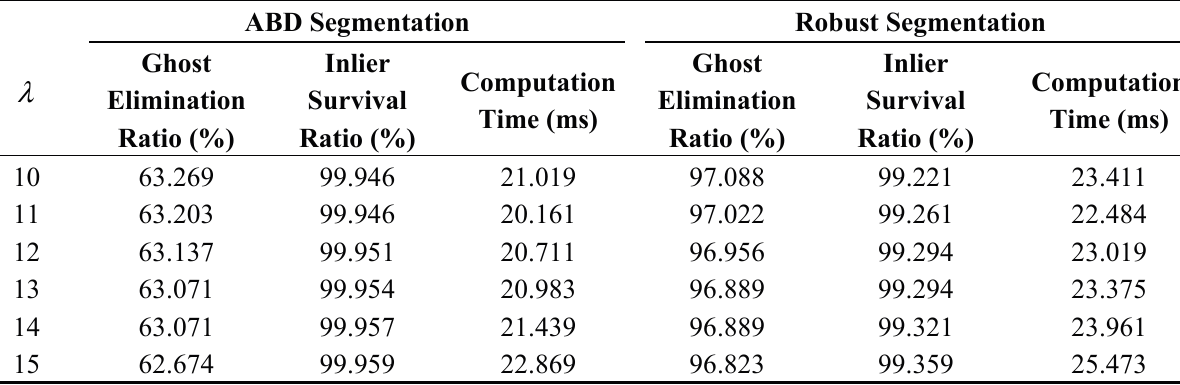
Table 7. Results of ghost elimination in foggy